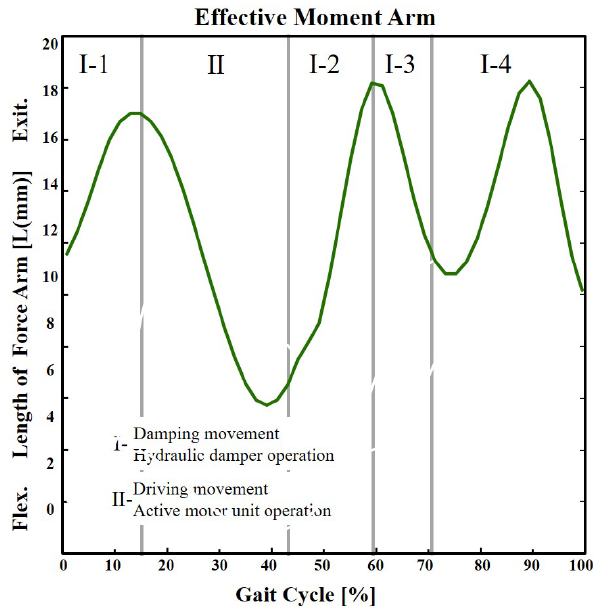
Figure 10. Effective moment arm.